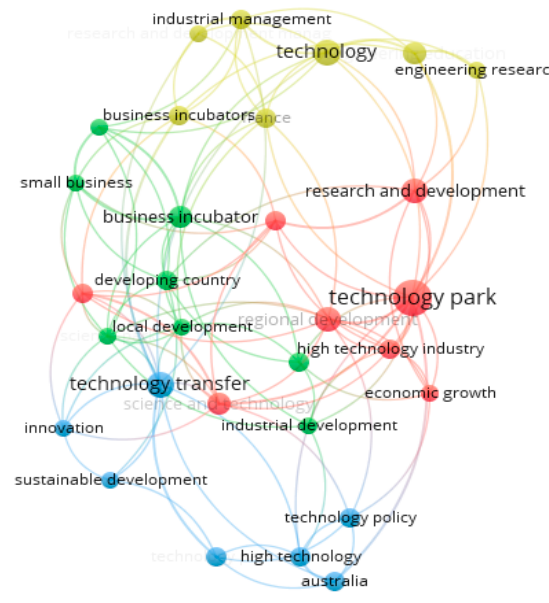
Figure 3. Cluster map 1975–1999.